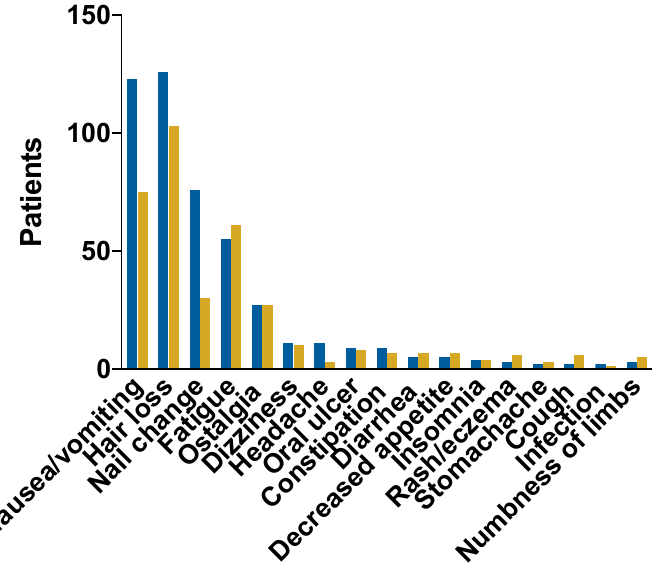
Figure 2. The number of common non-hematological all-grade adverse events by regimen. More nausea/vomiting (87.86% vs. 55.56%, p < 0.001), hair loss (90.00% vs. 76.30%, p < 0.01) and nail change (54.29% vs. 22.22%, p < 0.001) were reported in EC. Abbreviations: EC = epirubicin and cyclophosphamide; TC = docetaxel and cyclophosphamide. Table 4. Non-hematological toxicity by group. EC n = 140 (%) TC, n = 135 (%) Any Grade Grade 3–4 Any Grade Grade 3–4 123